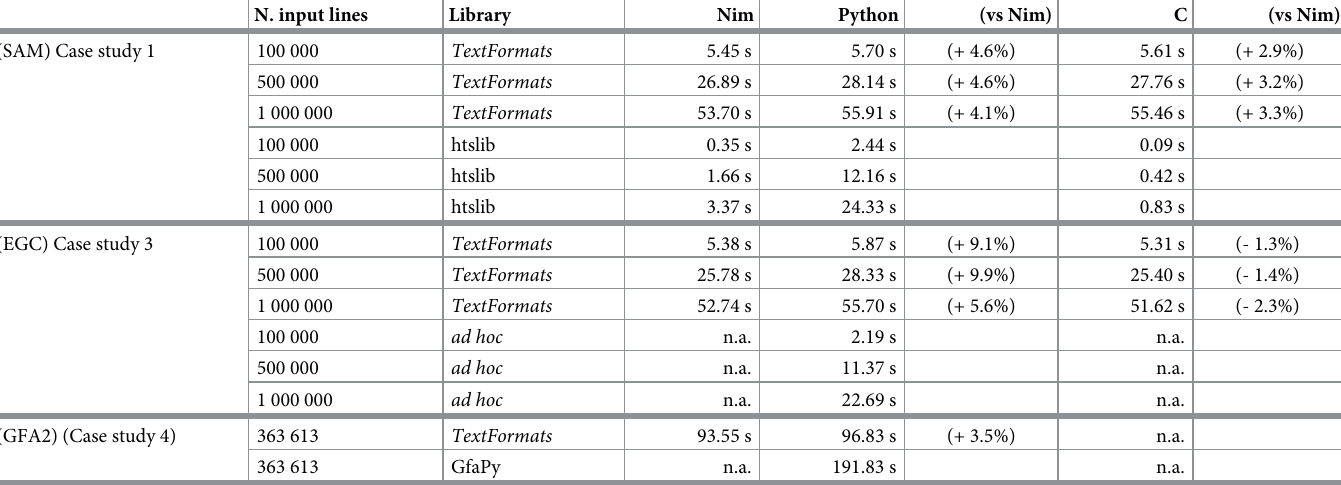
(SAM) Case study 1: program for collecting information from a SAM file, based on the TextFormats or the htslib library; (EGC) Case study 3: program for parsing the EGC format (defined in the text) writing the information to JSON and then back to EGC, based on the TextFormats library, or as a ad hoc Python parser; (GFA2) Case study 4: Python program for validating a GFA2 file and collecting basic statistics on the file, based on TextFormats library or on the GfaPy library; (vs Nim) Running time difference of the Python or C version (when implemented) of the TextFormats -based programs to the Nim version; The reported times are the average over 3 runs of the real time measured by GNU time , on a Linux OpenSuse 15.3 workstation (CPU i5–4570 3.2 Ghz, RAM 16 Gb), using TextFormats